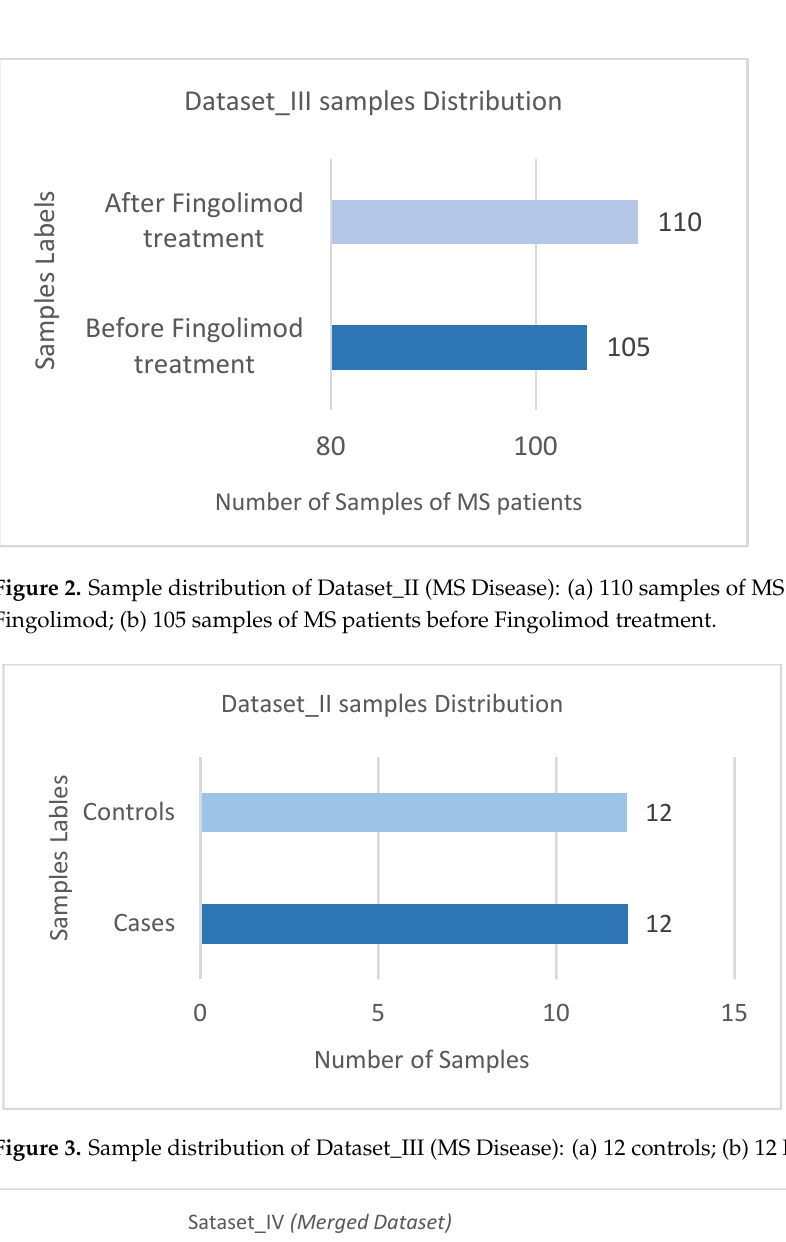
(A, B, C, D, and E) and each of these synthetic classes consists of six samples.